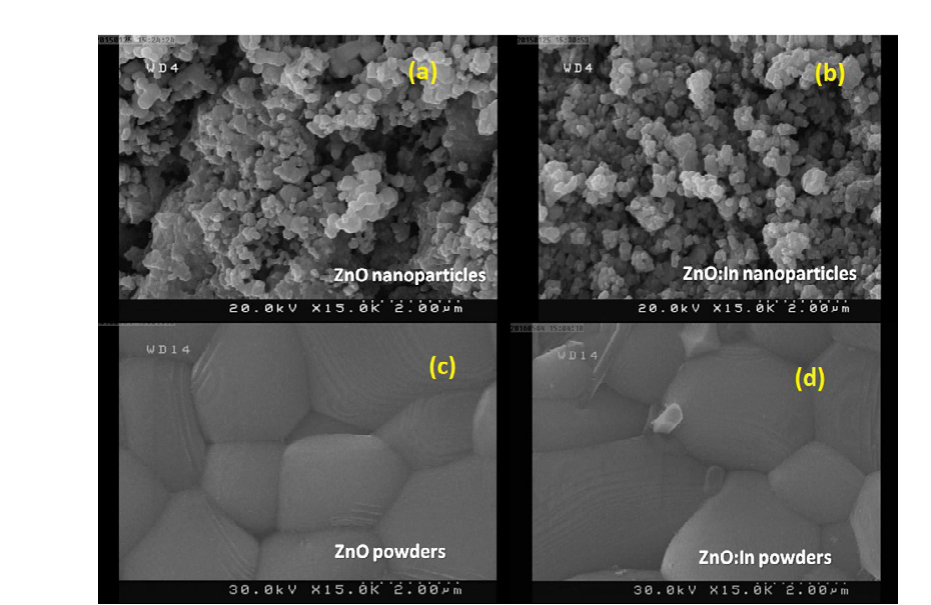
Fig. 3: SEM images of the prepared samples (a) ZnO dried at 300°C (b) IZO nanopowders dried at 300°C (c) ZnO calcined at 600°C and tablet preparation (d) IZO calcined at 600°C and tablet